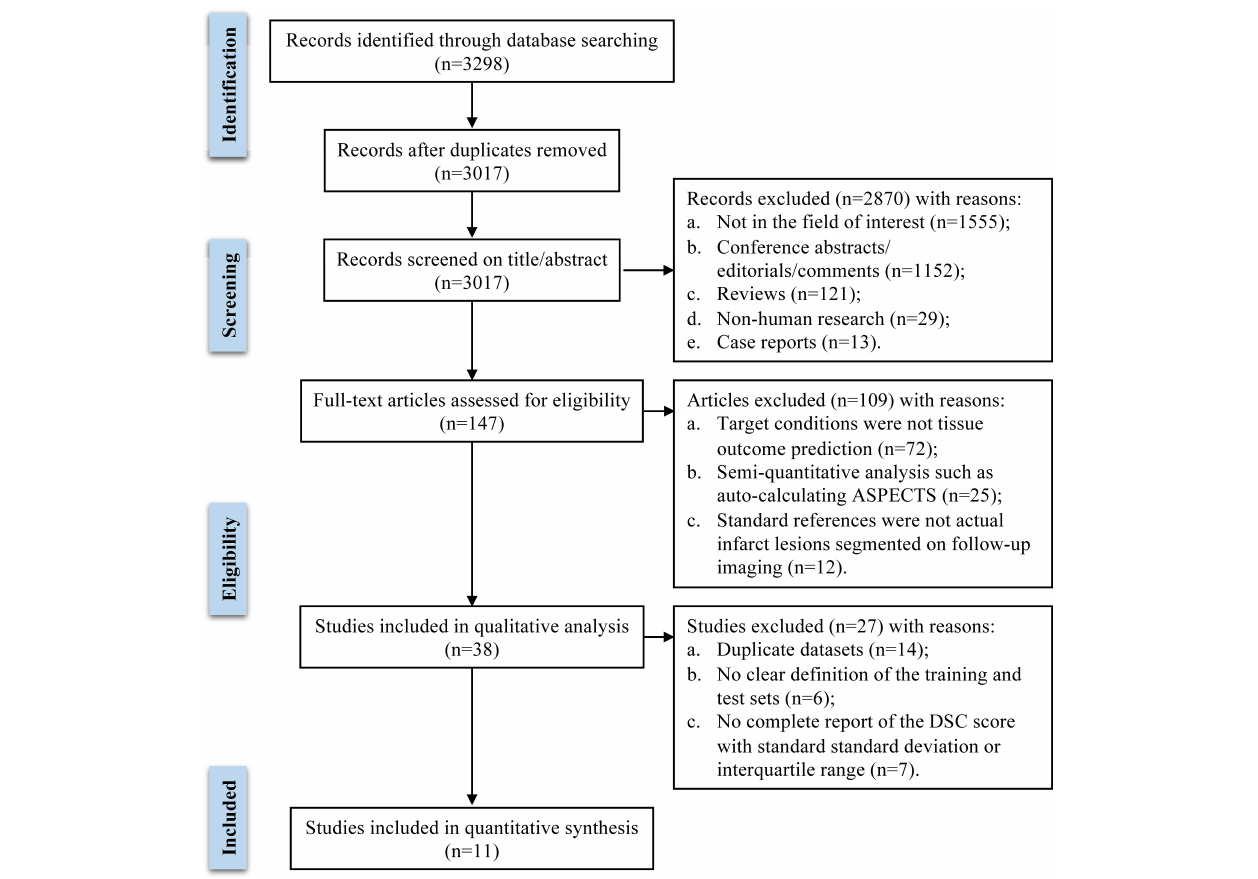
FIGURE 1 | Flow diagram of literature review and study selection